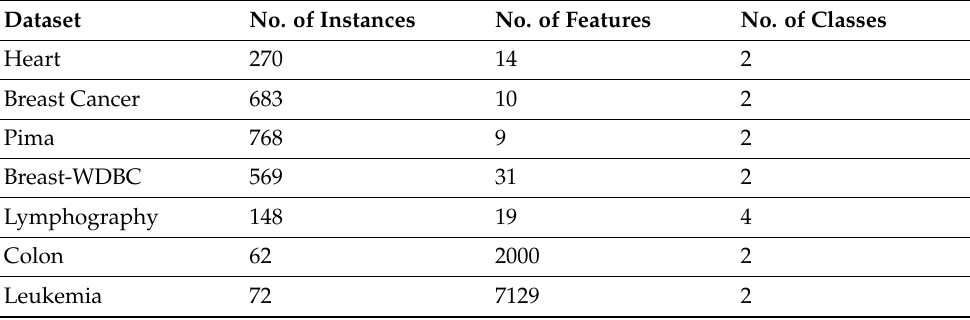
Table 2. Statistical information of